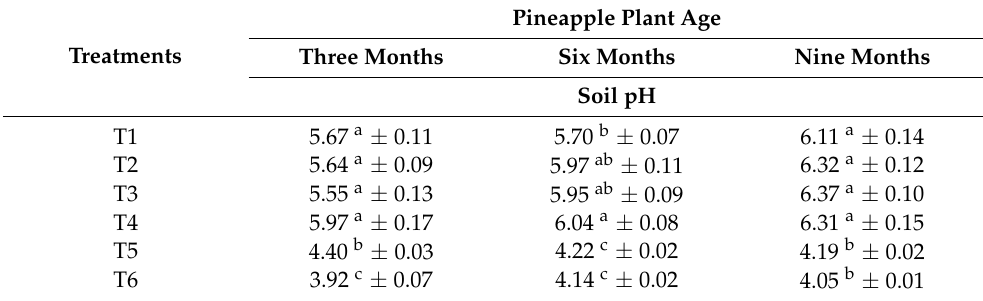
Pineapple Plant